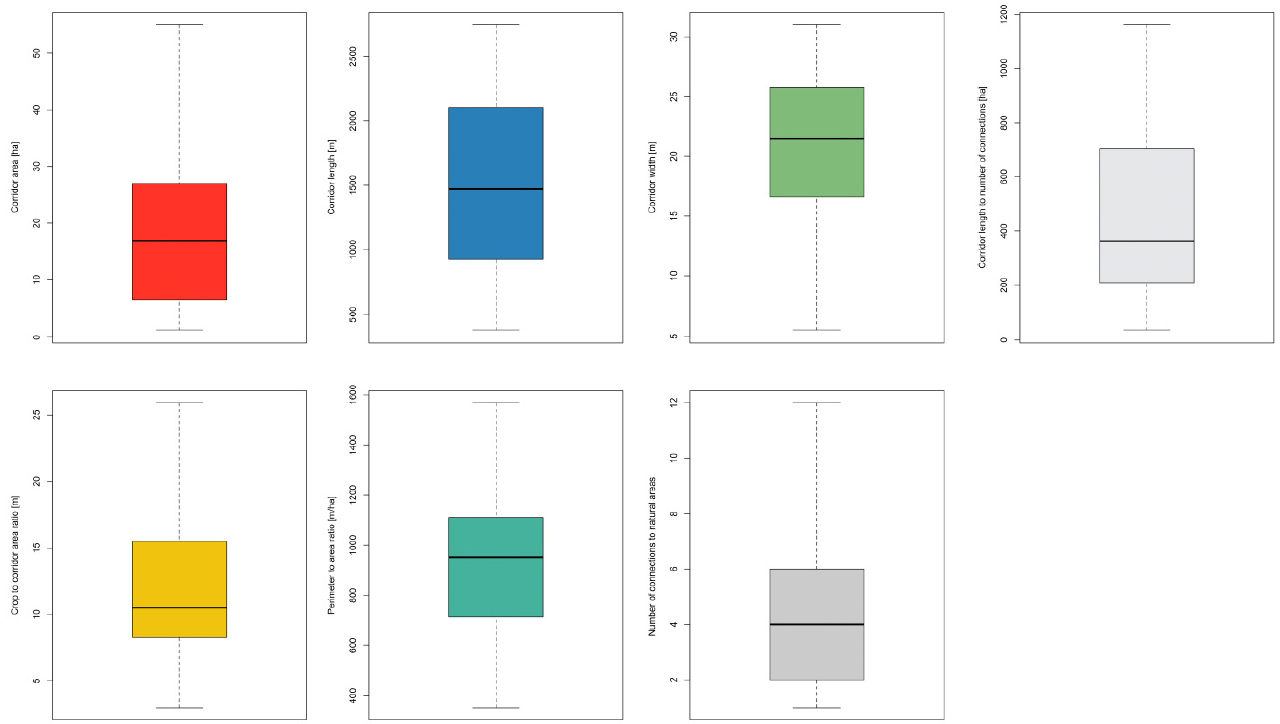
Figure 3. Box plots of attributes of the sampled corridors ( n = 22).